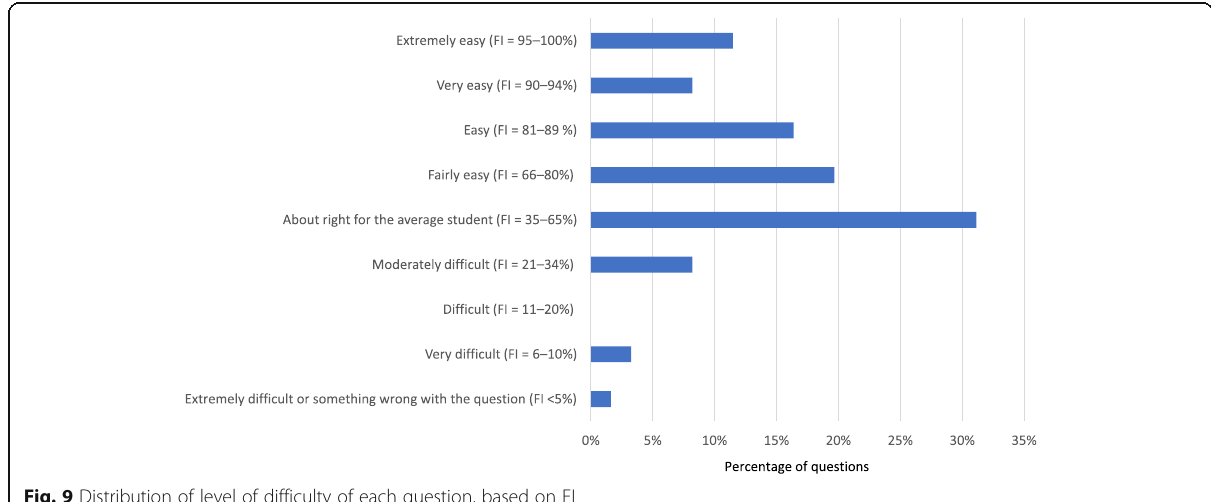
Fig. 9 Distribution of level of difficulty of each question, based on